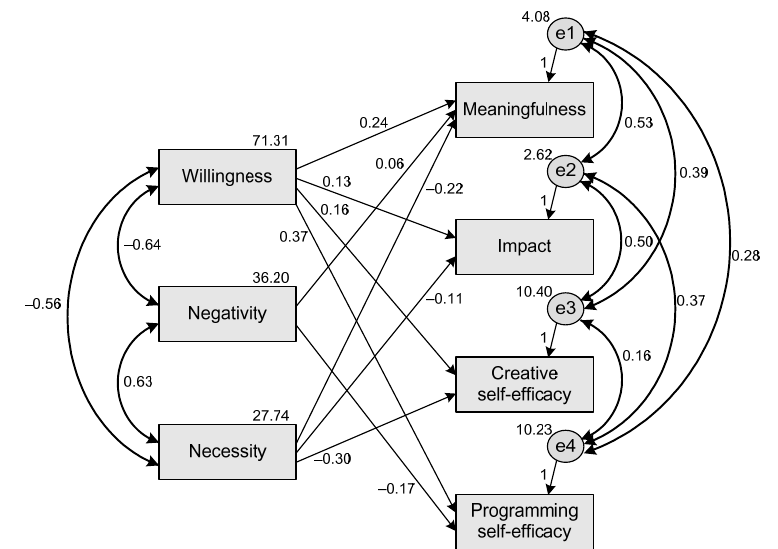
Figure 2. The SEM of CPLA to